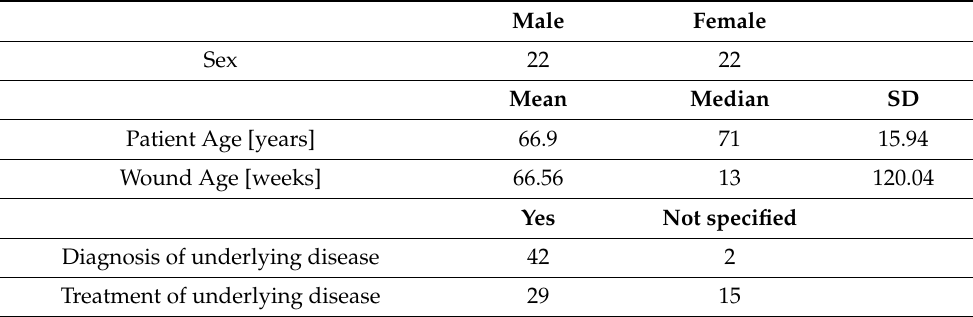
Table 2. Baseline of BC_A Post-Market Clinical Follow-up